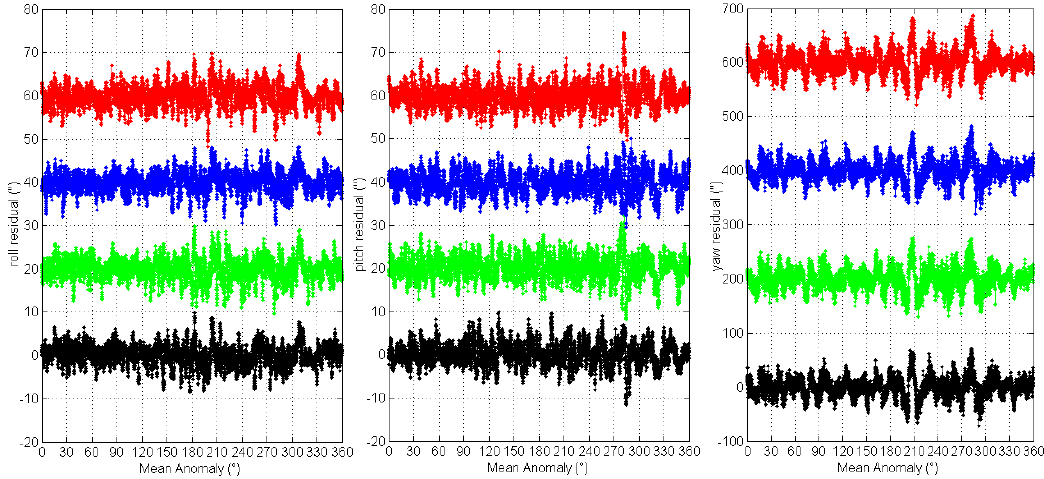
Figure 6. The 3-axes Euler angle residual streams of CCD01 vs. satellite mean anomaly.